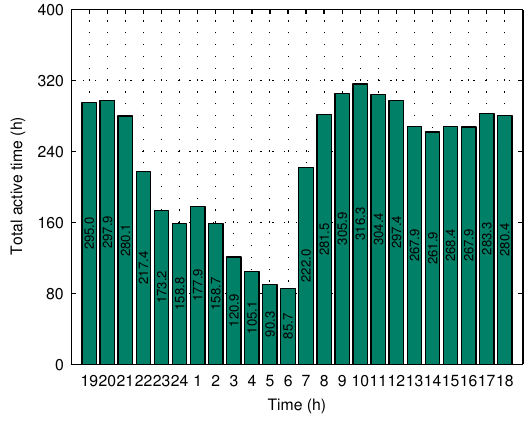
Figure 9. Total active time of